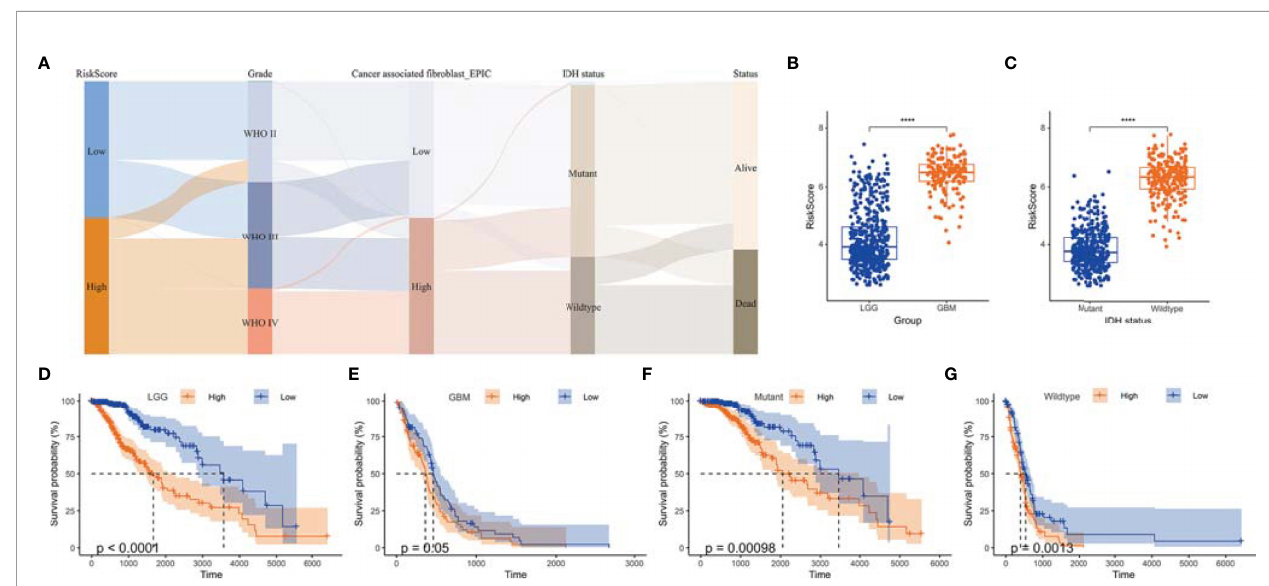
FIGURE 7 | The value of risk scores in predicting prognosis. (A) Sankey diagram displayed the distribution of risk score, IDH status, survival status, WHO grade, and TAF in fi ltration of gliomas in TCGA GBMLGG cohort. (B) Boxplot showed that GBM had a higher risk score relative to LGG in TCGA GBMLGG cohort. (C) Boxplot showed that the risk scores of IDH wild-type group was higher than that of the mutant group in TCGA GBMLGG cohort. (D-G) Kaplan – Meier curves displayed prognostic differences between high- and low-risk groups in different WHO grades and IDH status subtypes. ****, p <